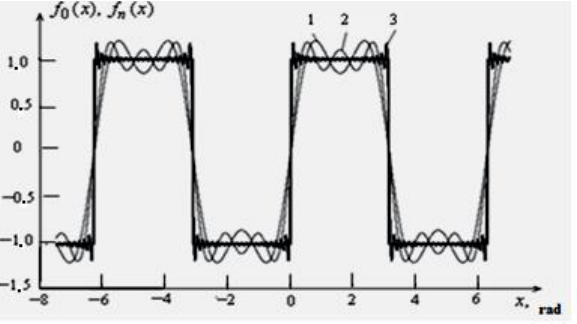
Figure 5. Errors in approximation of a piecewise linear function using Fourier series expansion.